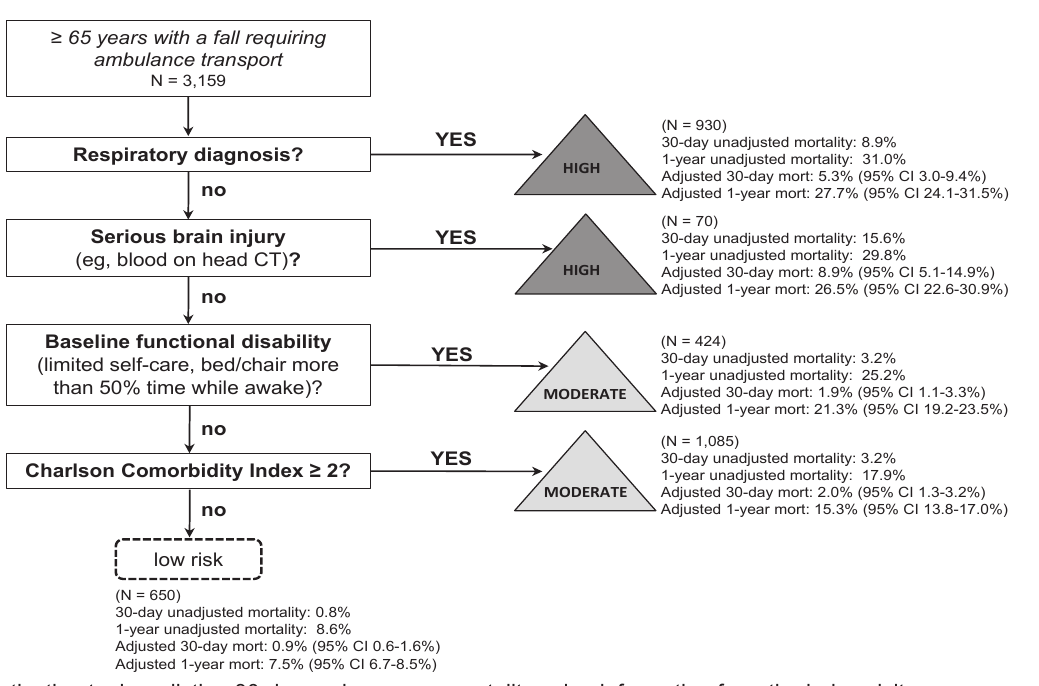
Figure 3. Prognostication tool predicting 30-day and one-year mortality using information from the index visit among community-dwell- ing older adults requiring ambulance transport after a